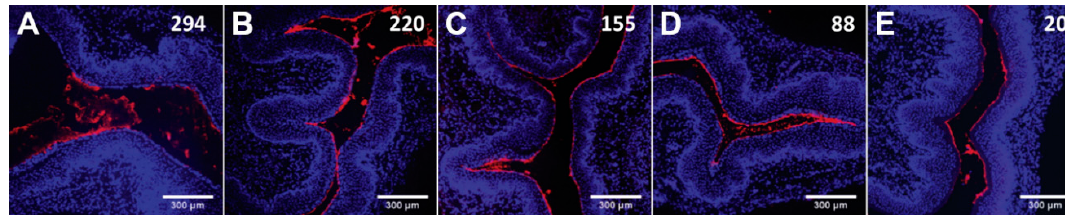
Figure 2. Vaginal distribution of fluorescent 100 nm mucus-penetrating particles administered in suspensions of varying osmolality. ( A – E ) Distribution of mucus-penetrating particles in transverse vaginal cryosections. Values of osmolality are presented in the individual images and have mOsm/kg as units. Images are representative of n ≥ 5 mice. Adapted from [84], Copyright (2013), with permission from Elsevier.